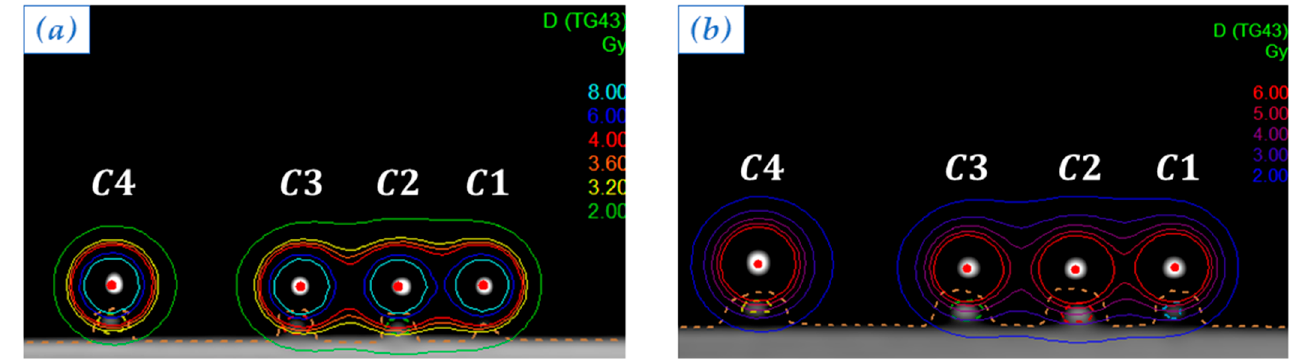
Figure 5. Isodose curves obtained by optimizing the 3 mm slice thickness plan with four active dwell positions ( a ) and the 1 mm slice thickness plan with four active dwell positions ( b ). Each color corresponds to a dose value, as reported in the legend